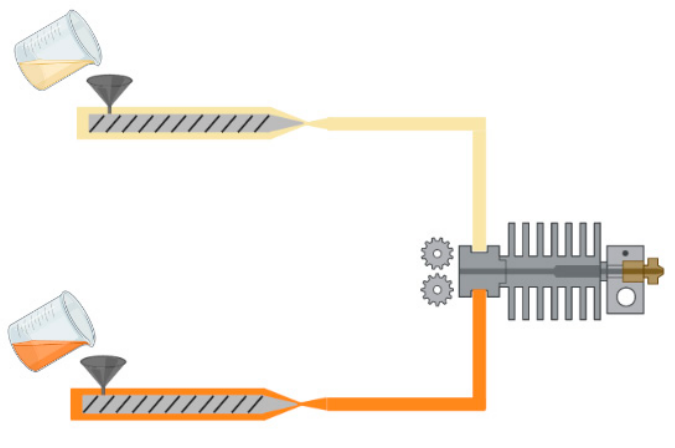
Figure 4. Schematic of process of bilayer film formation by the extrusion